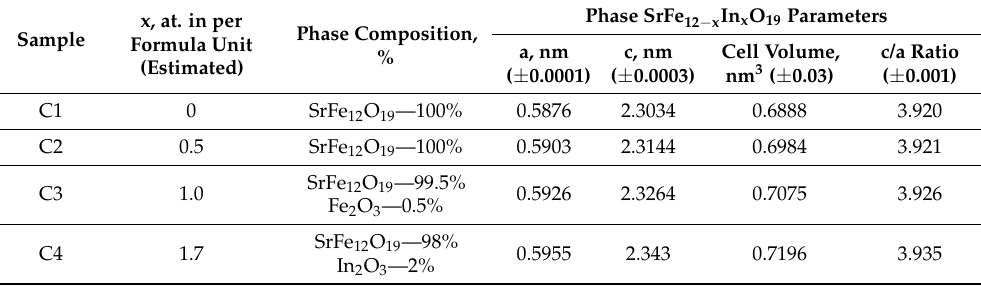
Table 3. Phase analysis of SrFe 12 − x In x O 19 samples obtained by the citrate method and annealed at 1200 ◦ C for 1